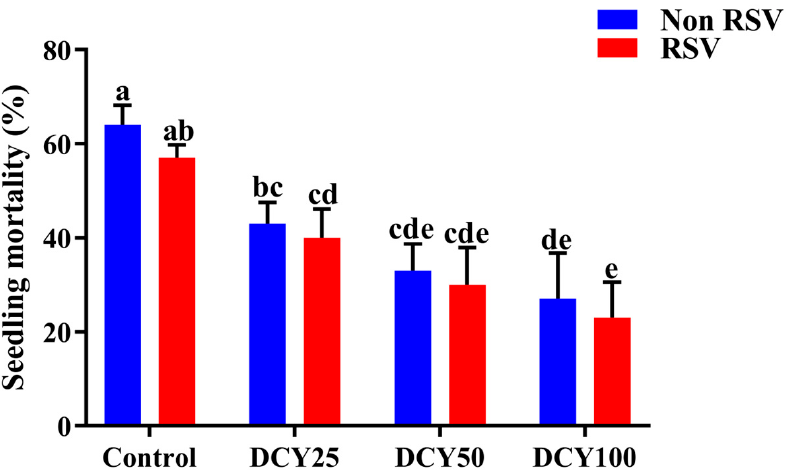
Figure 4. Mortality of DCY-treated rice seedlings fed with different populations of SBPH. Significant differences between treatments are indicated by the letters (a, b, c, d, and e) ( p < 0.05, Tukey’s HSD test).